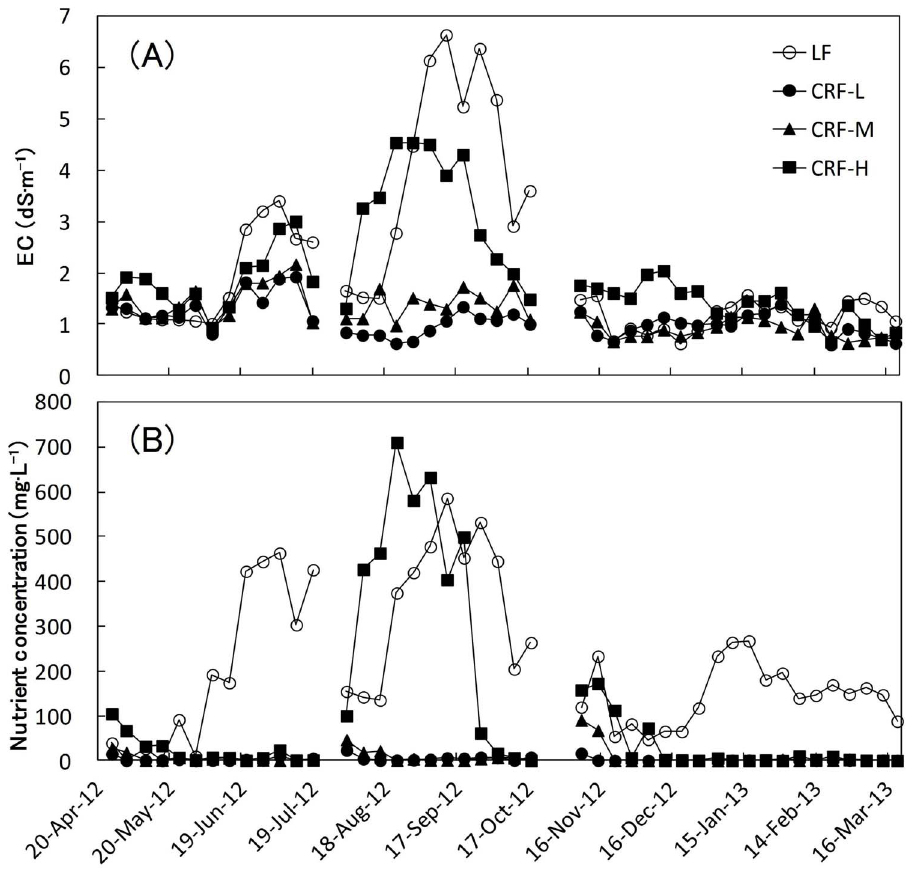
Figure 4. EC (A) and nutrient concentration (nitrogen equivalent) (B) in the substrate solution with each cropping season.